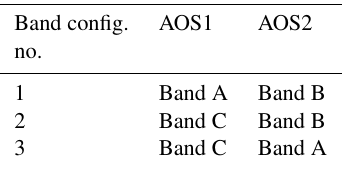
Table 2. Band configurations. Band